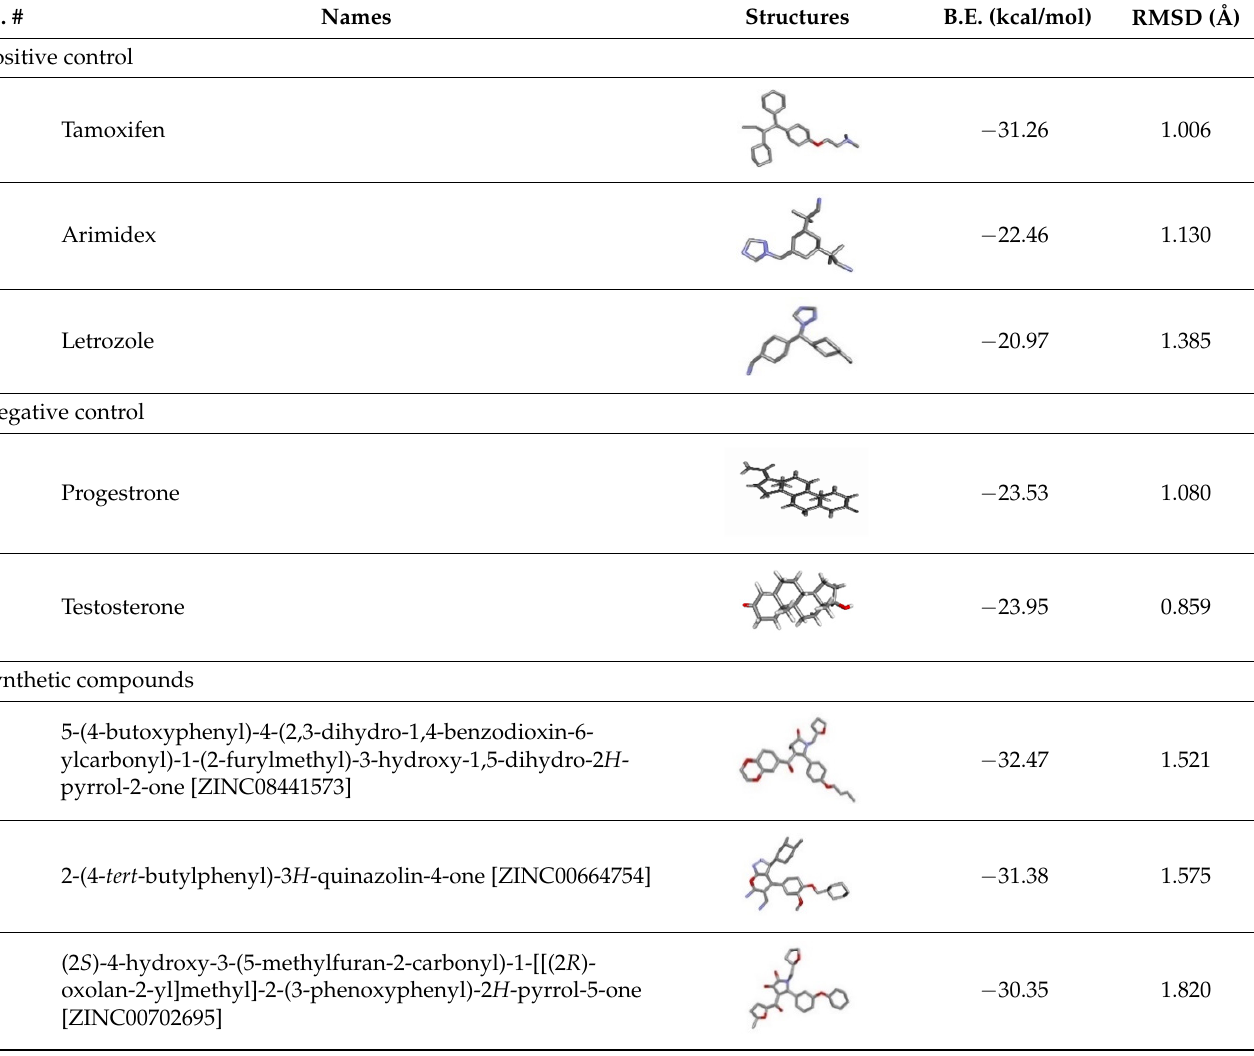
Table 3. Docking results of positive control, negative control, synthetic and natural compounds with ER α protein. S. #